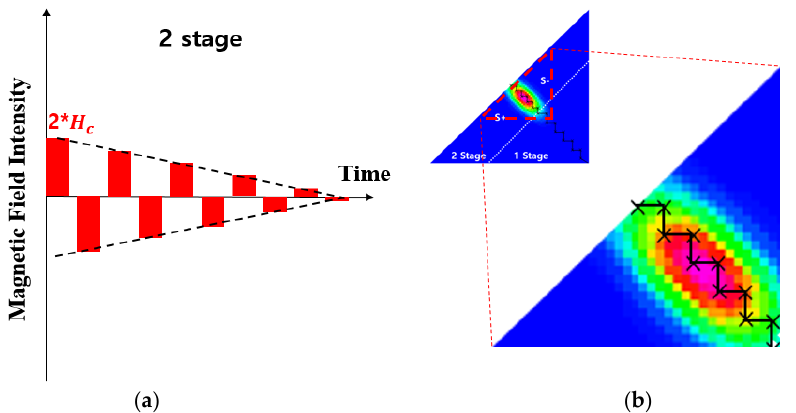
Figure 7. Schematic view of Stage 2 of the proposed protocols: ( a ) Stage 2 of the proposed protocol; ( b ) the traces on the Preisach plane.